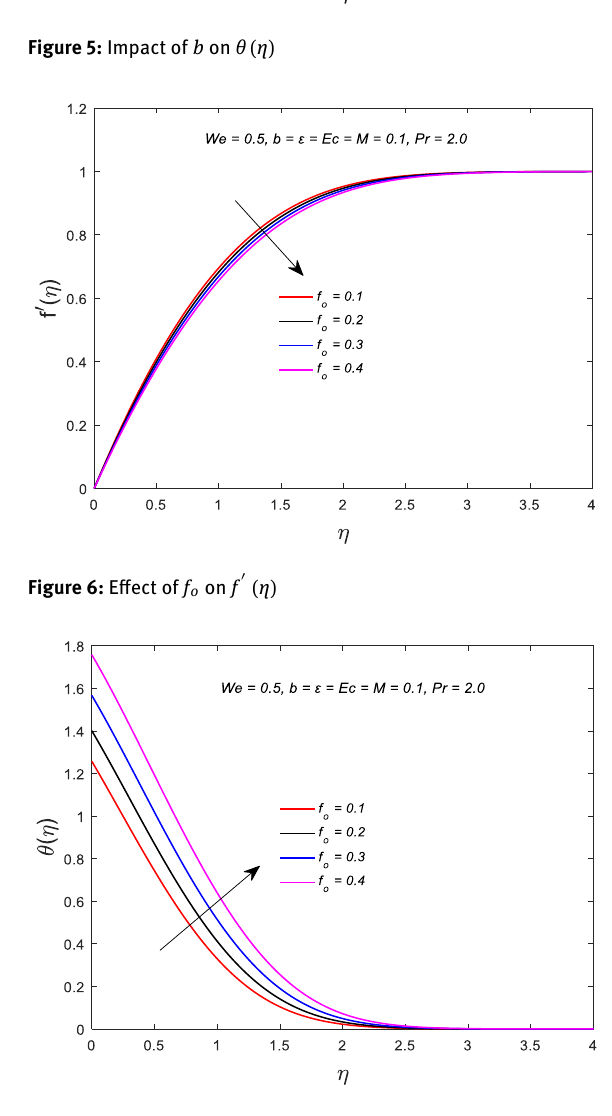
Figure 7: Impact of f o on θ ( η )